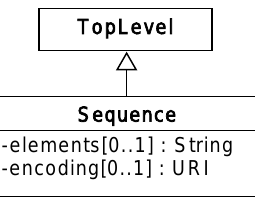
Figure 7: Diagram of the Sequence class and its associated